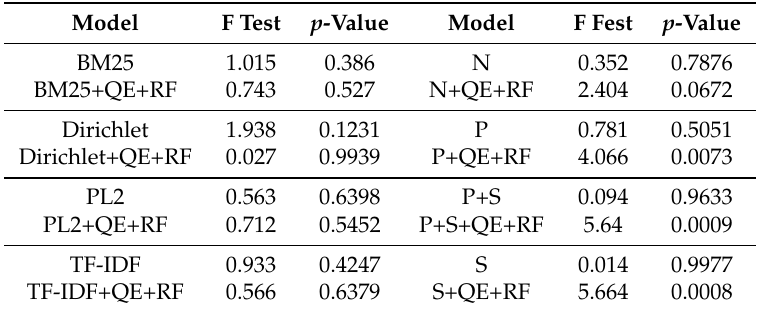
Table 29. T2: ANOVA test results for the different models and indexes for